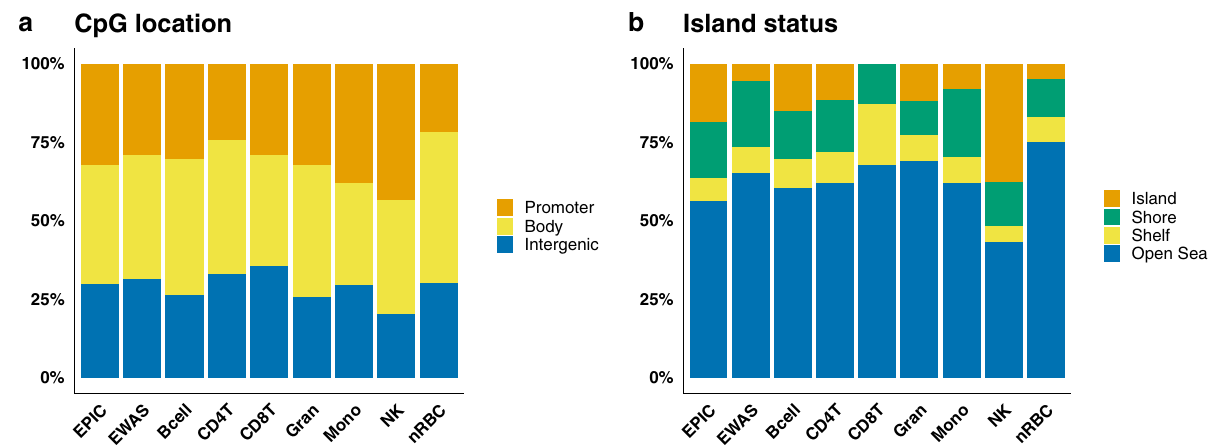
Fig. 5 Position enrichment results of CpGs associated with GA compared to all CpGs on the EPIC array. Position enrichment results of all the CpGs on the EPIC array ( n = 770,586; denoted as EPIC on the x-axis), those speci fi cally associated with GA in the conventional EWAS ( n = 13,660; EWAS), and each cell type in the CellDMC analyses in START (Bcell, n = 53; CD4T, n = 103; CD8T, n = 31; Gran, n = 136; Mono, n = 37; NK, n = 157; nRBC, n = 2030). a The proportion of CpGs in the promoter (orange), gene body (yellow), and intergenic (blue) regions. b The proportion of CpGs in CpG islands (orange), shores (green), shelves (yellow), and open sea (blue). Bcell B-cell, CD4T CD4 + T-cell, CD8T CD8 + T-cell, Gran granulocyte, Mono monocyte, NK natural killer cell, nRBC nucleated red blood